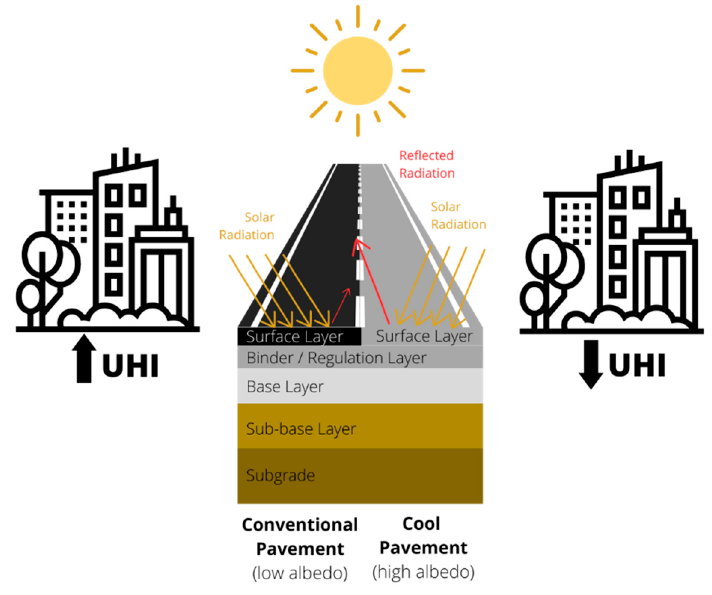
Figure 4. Cool vs conventional pavements.